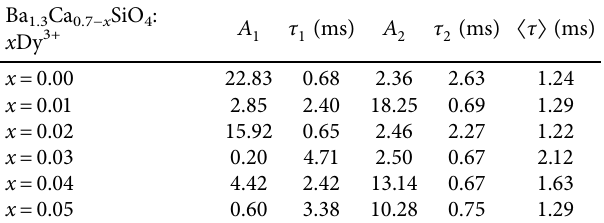
Table 3: PL decay curve parameters for the silicate